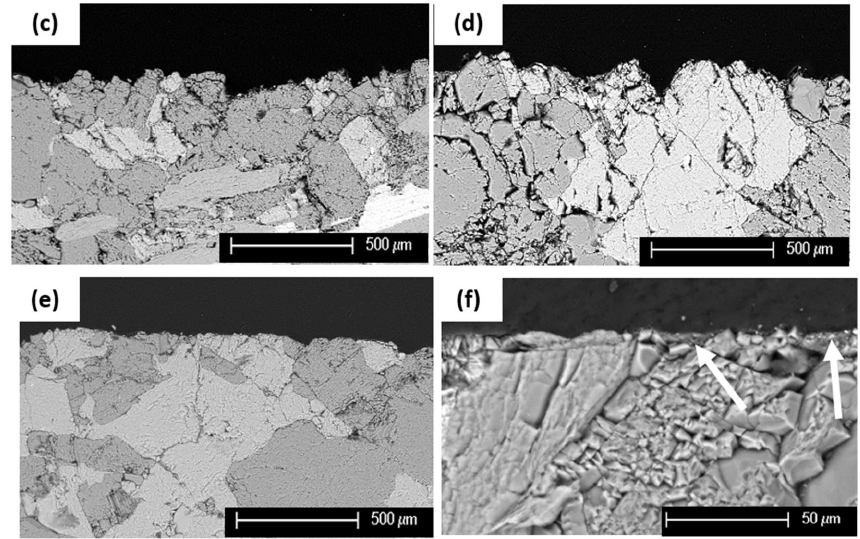
Figure 10. SEM micrographs of the cross sections of the reference granite ( a ) and some surfaces treated with the selected laser conditions to extract silver ( b —with UV radiation), blue ( c —with IR radiation; and d —with F IR / F UV : 1/3) and black ( e —with IR radiation; and f —with F IR / F UV : 3/1). Graffiti remains in ( f ) are pointed out with arrows. Detailed information on fluence values and pulses for each irradiation condition can be found in Table 2.